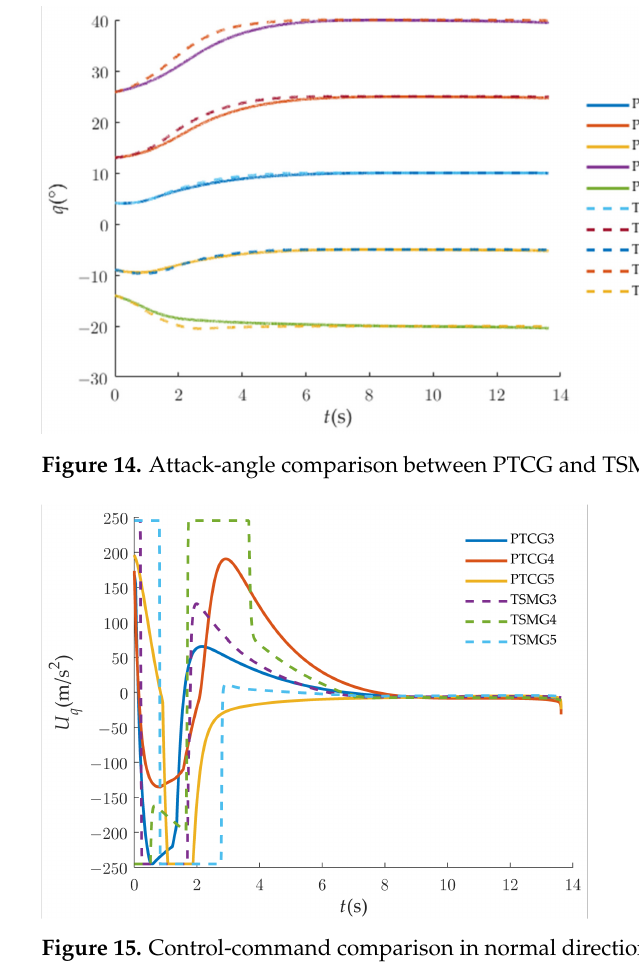
Figure 15. Control-command comparison in normal direction of